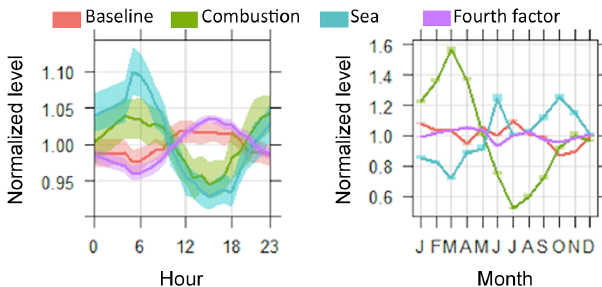
Figure 7. Mean and 95% confidence interval in mean of diurnal and seasonal cycles of four PMF